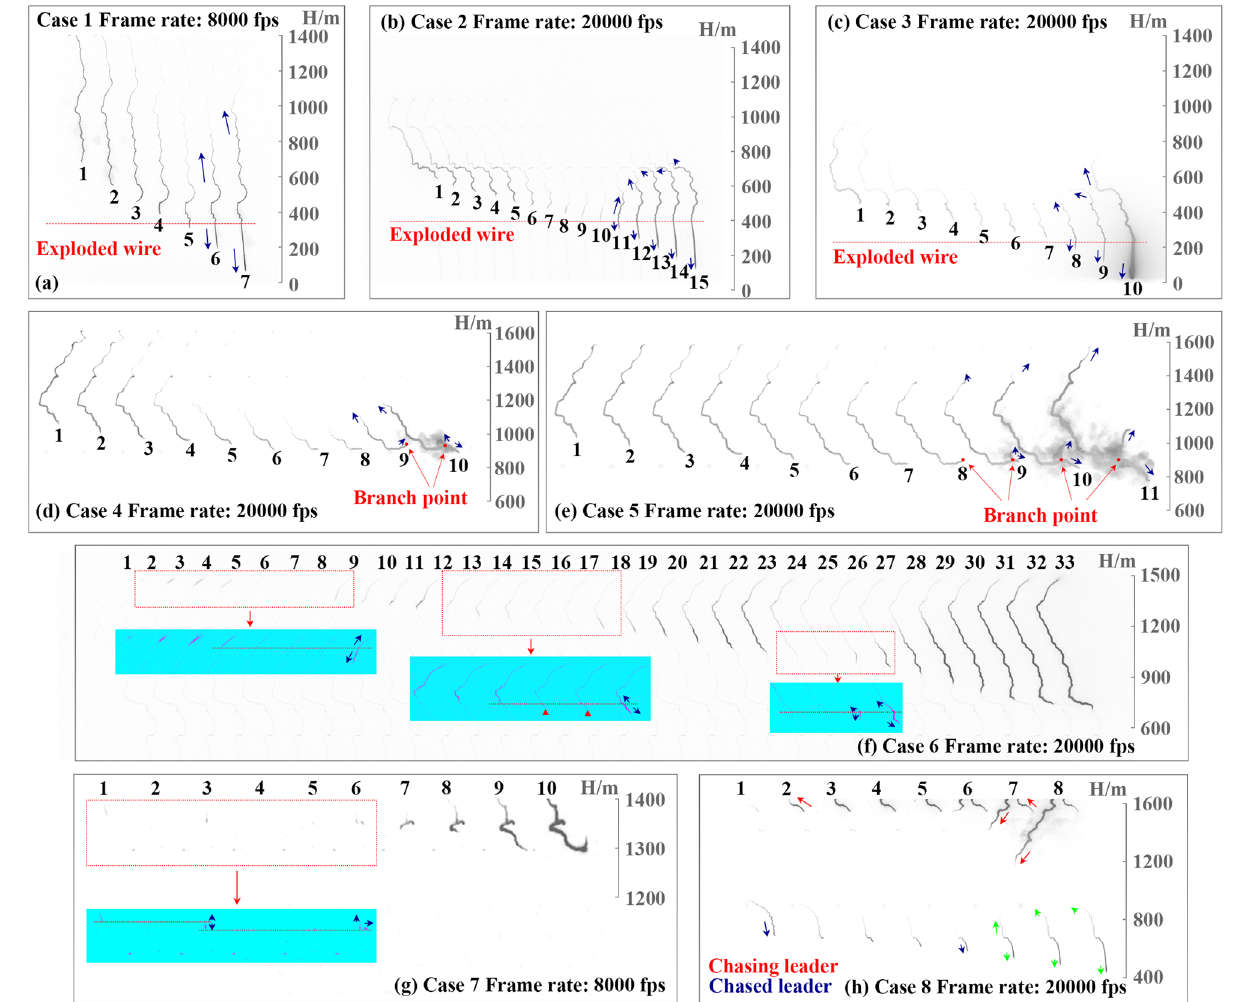
Figure 1. Consecutive frames revealing the eight cases of BL developments with background luminosity removed, contrast-enhanced, and intensity inverted. Some areas are recolored for a better presentation. Blue and green arrows show the bidirectional propagation of